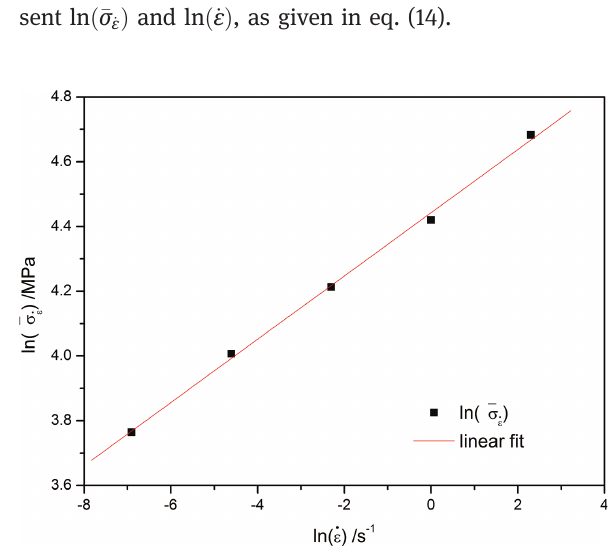
Figure 6: Relationship between ln ð (cid:2) σ _ ε Þ and ln ð _ ε Þ